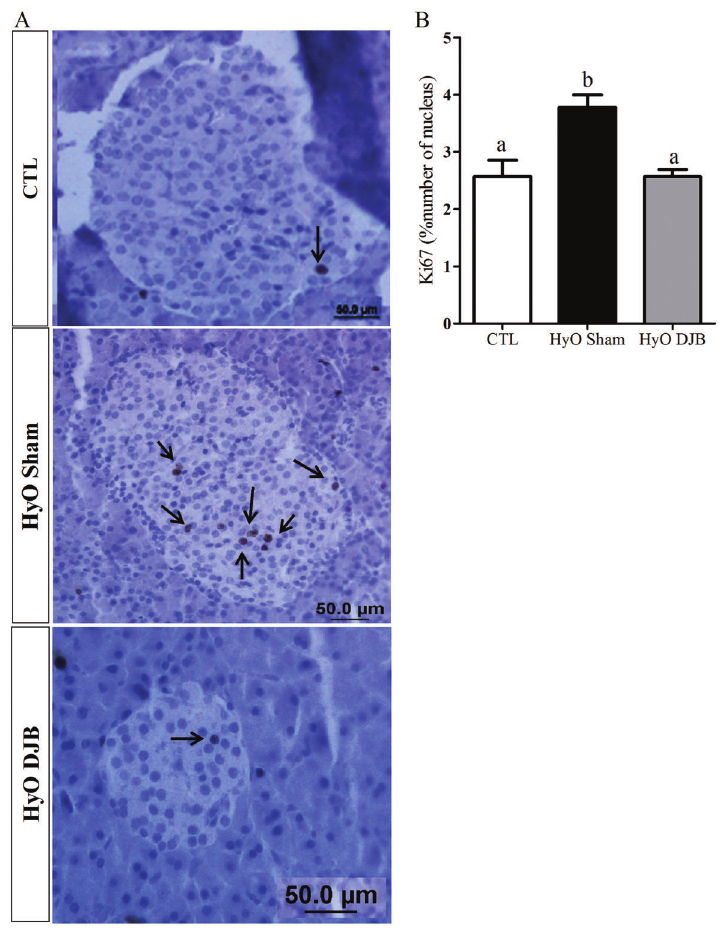
Figure 6. A , Representative images of pancreas sections stained for Ki67. B , Percent of Ki67 positive nucleus in the control (CTL), hypotha- lamic obese (HyO) Sham and HyO with duode- nal-jejunal bypass (DJB) pancreases. Arrows represent the nucleus stained by Ki67. Data are reported as means ± SEM (n=3 – 4). P o 0.05, different letters indicate signi fi cant differences (one-way ANOVA followed by the Tukey post-